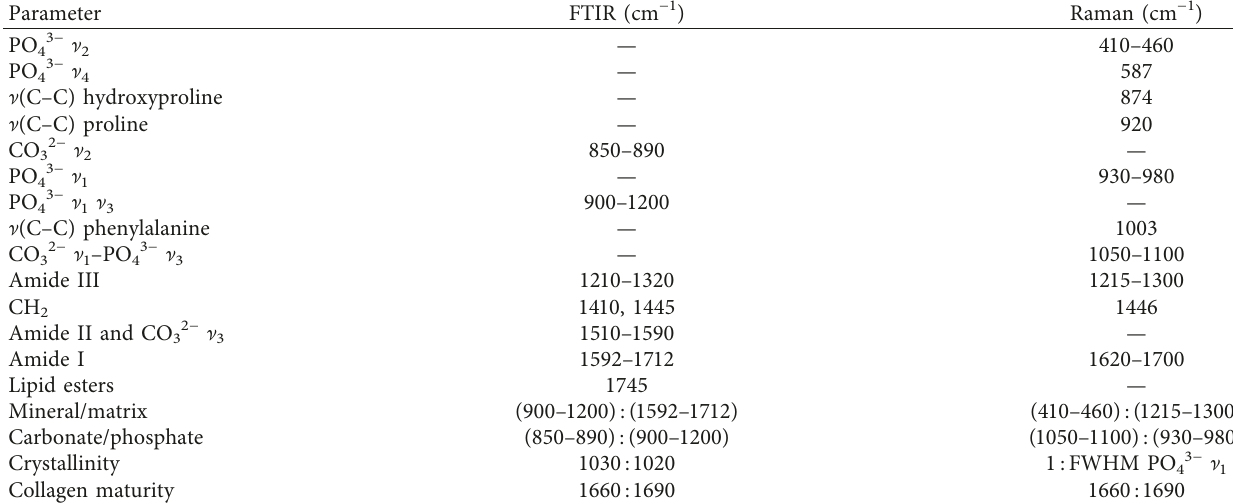
Table 1: Primary band assignments in the FTIR and Raman spectrum of bone and the four widely used outcomes.